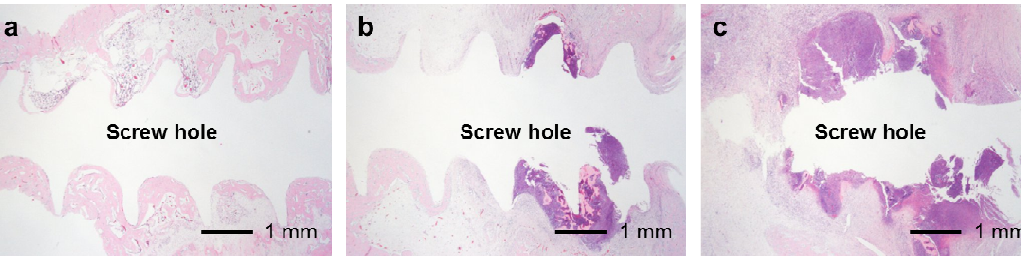
Figure 11. Percent incidence of Grades 0b, 1b, and 2b osteomyelitis determined by histological observation of ( a ) the UN1, 25F0.5, 25F1.0, and 37F4.0 groups; ( b ) the UN2 and 25F2.0 groups. : Grade 0b, : Grade 1b, : Grade 2b. * p <